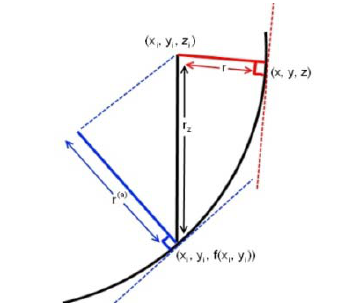
Figure 3: The algebraic residual compared with the orthogonal residual for a